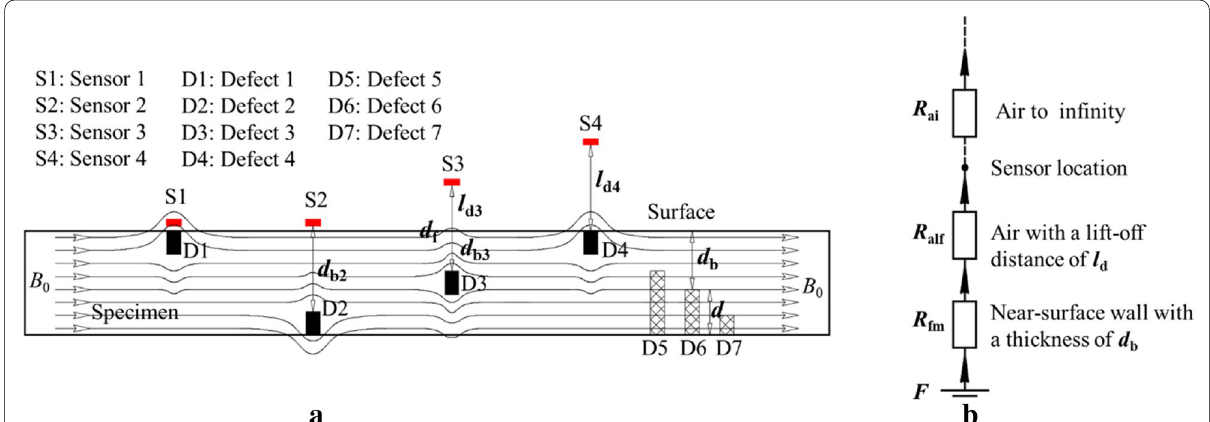
Figure 1 The magnetic flux leakage model of inner defects: ( a ) schematic of MFL testing for inner defects with different buried depths; ( b ) magnetic circuit model of MFL course of inner